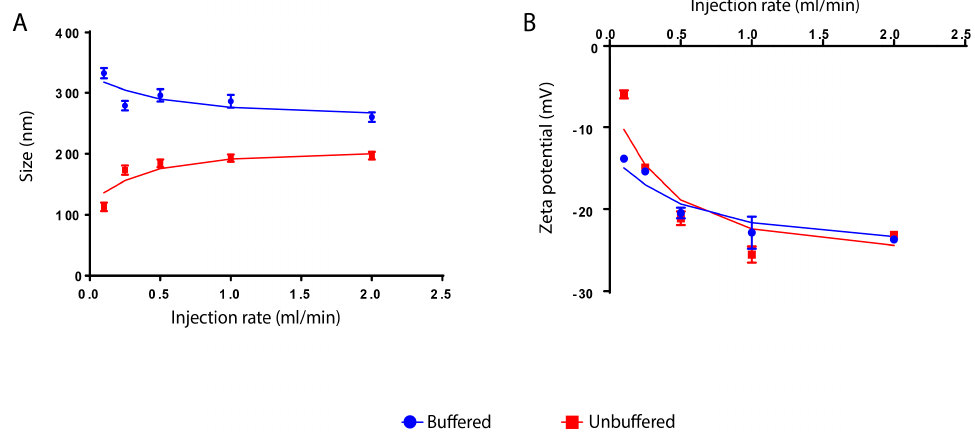
Figure 8. The effect of ethanol injection rate on the size ( A ) and zeta potential values ( B ) of BSA nanoparticles dispersed in water and in phosphate buffer 10 mM, at pH 7. Measurements from separate assays were combined ( n = 6) and showed in mean ± SD.